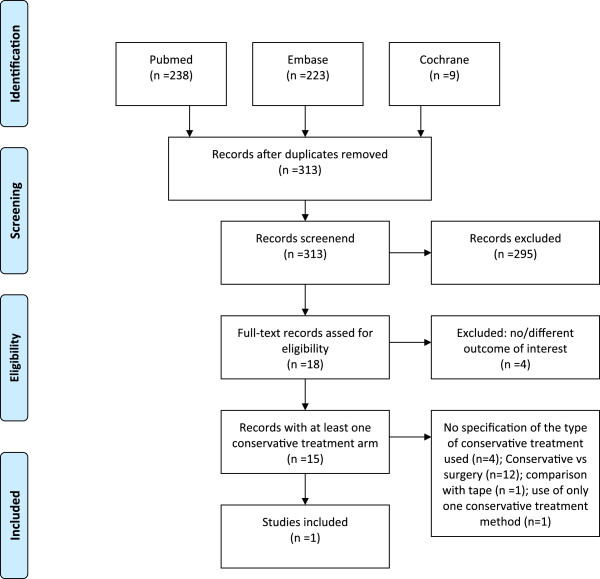
Flow chart review.